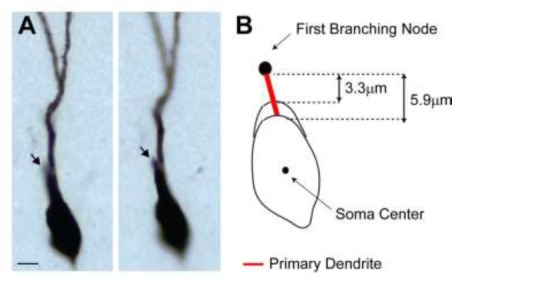
(A) Representative pictures of the cell id 103 at two different focal planes.Note the presence of a single apical primary dendrite. The arrow points to the initial segment of a secondary dendrite, which continues in the neighboring section. (B) Schematic diagram showing the jitter in estimating the length of short primary dendritic segments, depending on the shape (i.e. more or less elongated) of the somatic contour.